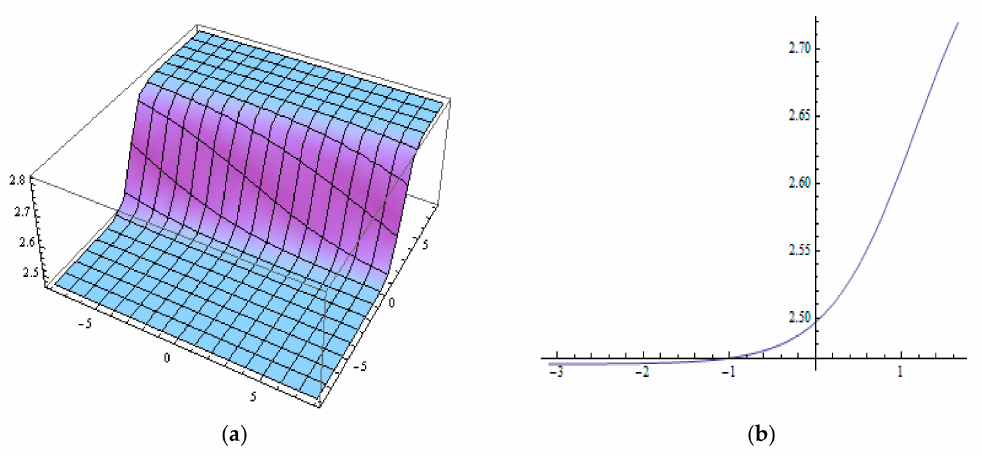
Figure 4. ( a ) The Absolute value of exact solution Q 28 when s 0 = 2, ε = 0.2, α = − 2, σ = 0.1, η = 2, ζ = 1, q = 11 and ( b ) is the projection of Q 28 in 2D.